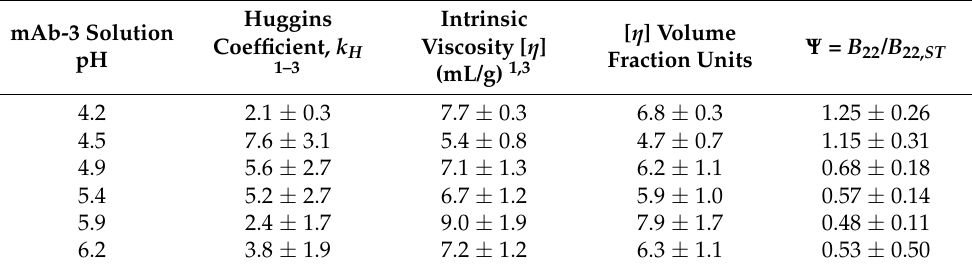
Table 4. Huggins coefficient k H , intrinsic viscosity [ η ], and the normalized osmotic second